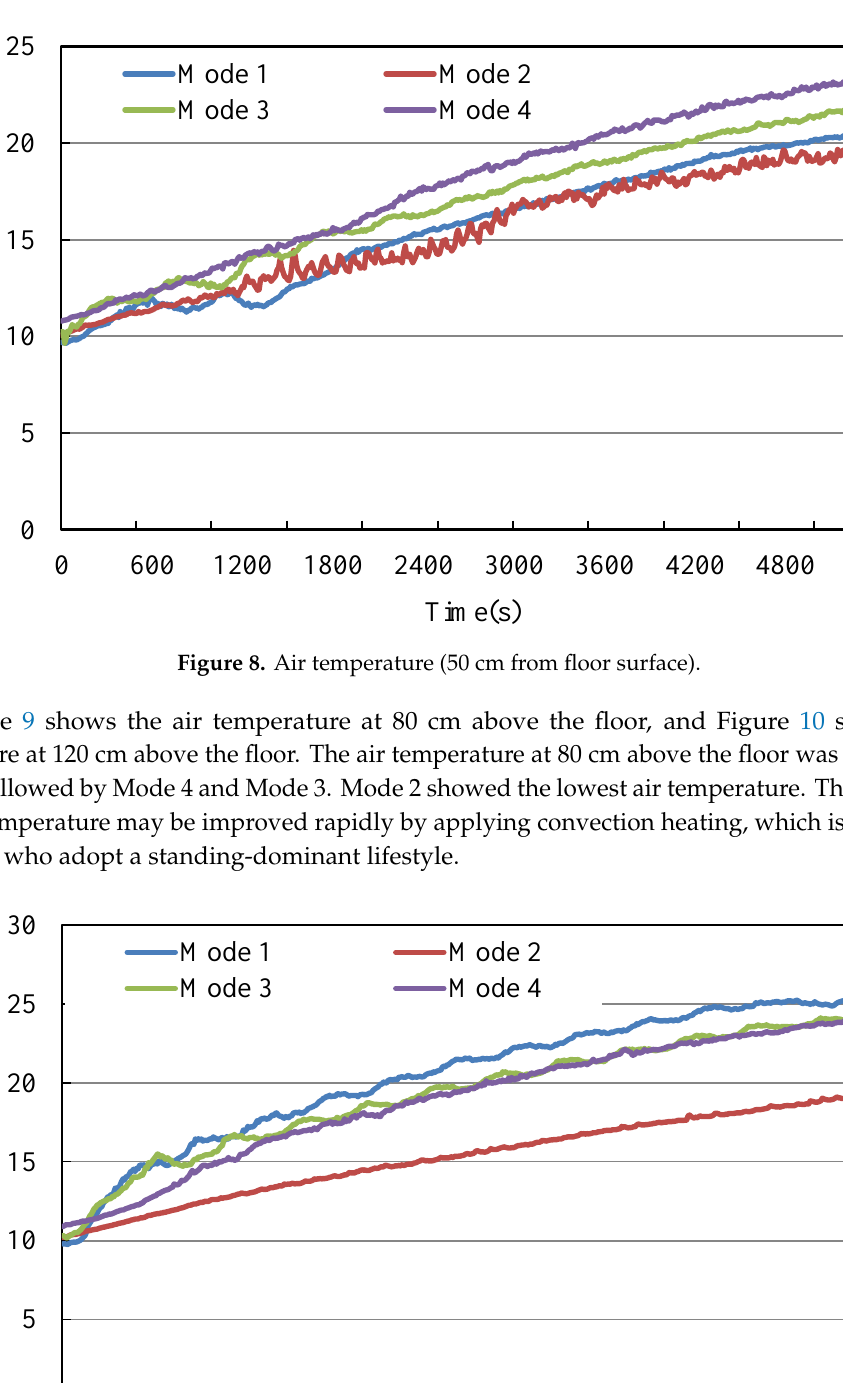
Figure 9. Air temperature (80 cm from floor surface).